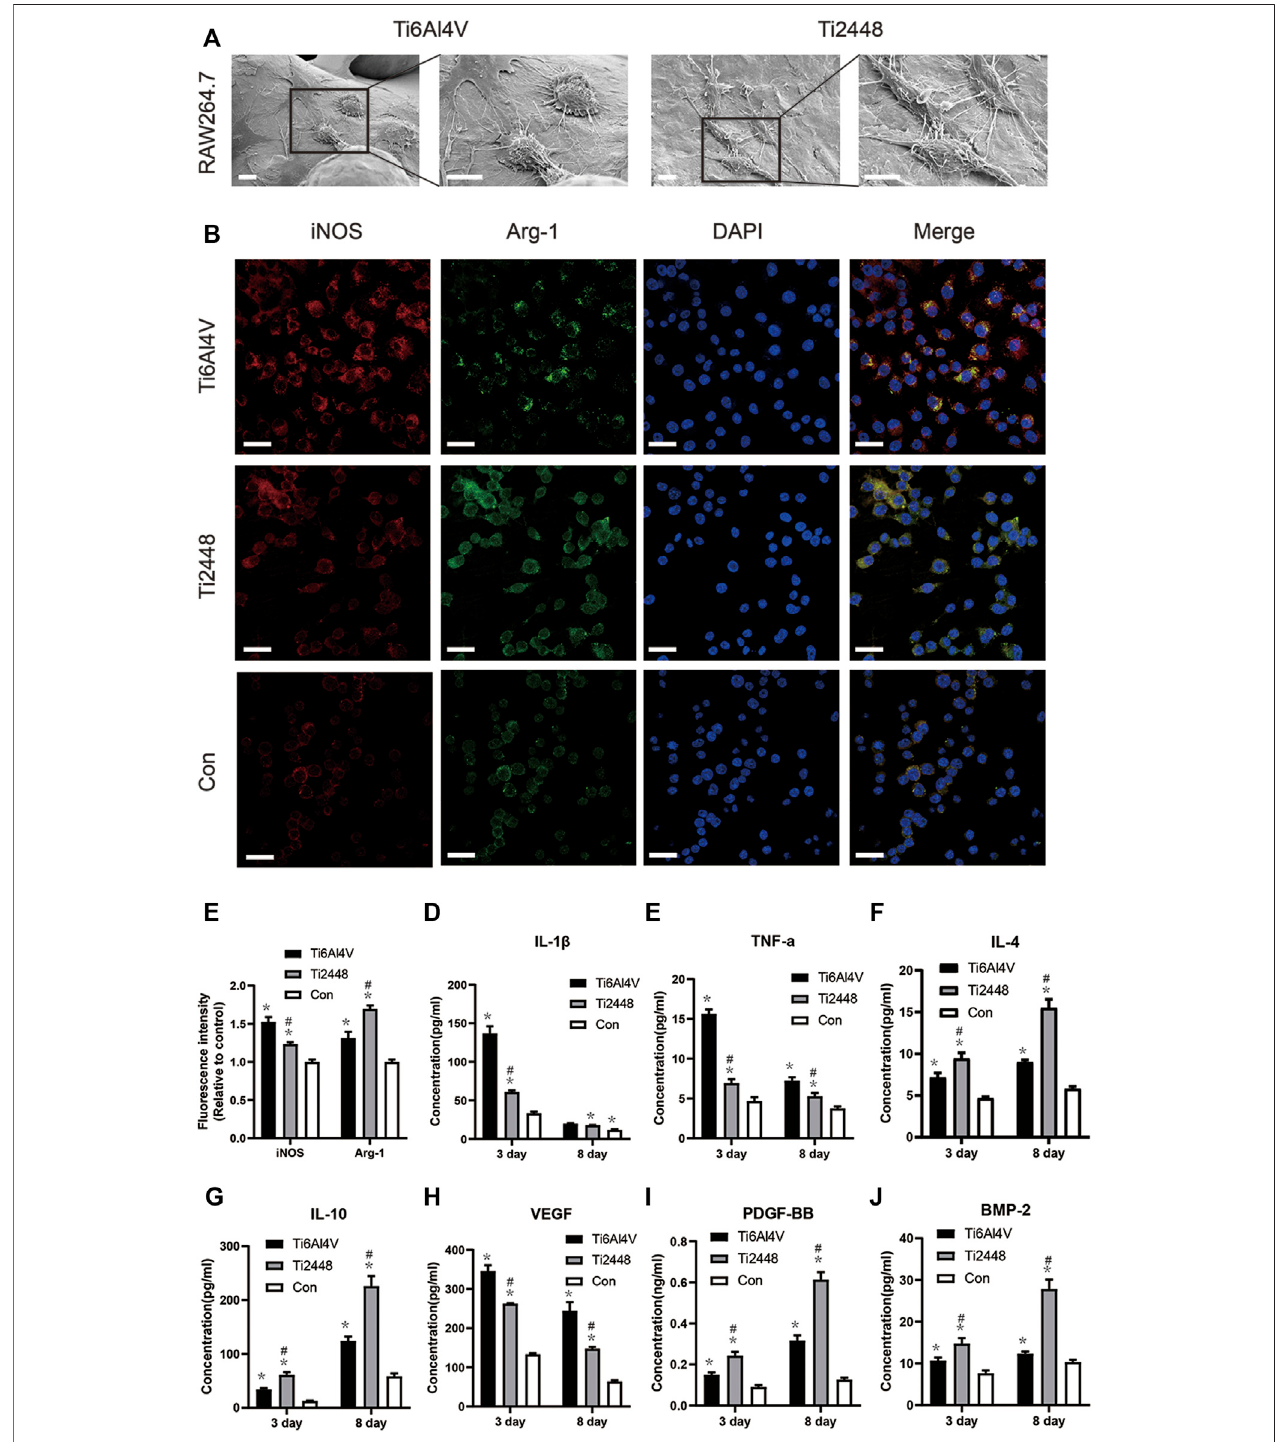
FIGURE 11 | Scaffold stiffness modulates macrophage in fl ammatory activation. Morphological observation of macrophages on different scaffold surfaces. Scale bar (cid:2) 100 µm (A) . Immuno fl uorescence staining for iNOS (red, M1 macrophages) and Arg-1 (green, M2 macrophages). Scale bar (cid:2) 20 µm (B) . Quantitative analysis of immuno fl uorescenceintensity (C) .LevelsofIL-1 β andTNF- α secretedbyM1macrophages (D,E) ,IL-10andIL-4secretedbyM2macrophages (F,G) ,andVEGF,PDGF- BB and BMP-2 (H – J) at 3 and 8 days. Note: * p ＜ 0.05 compared to the control; # p ＜ 0.05 compared to Ti2448.